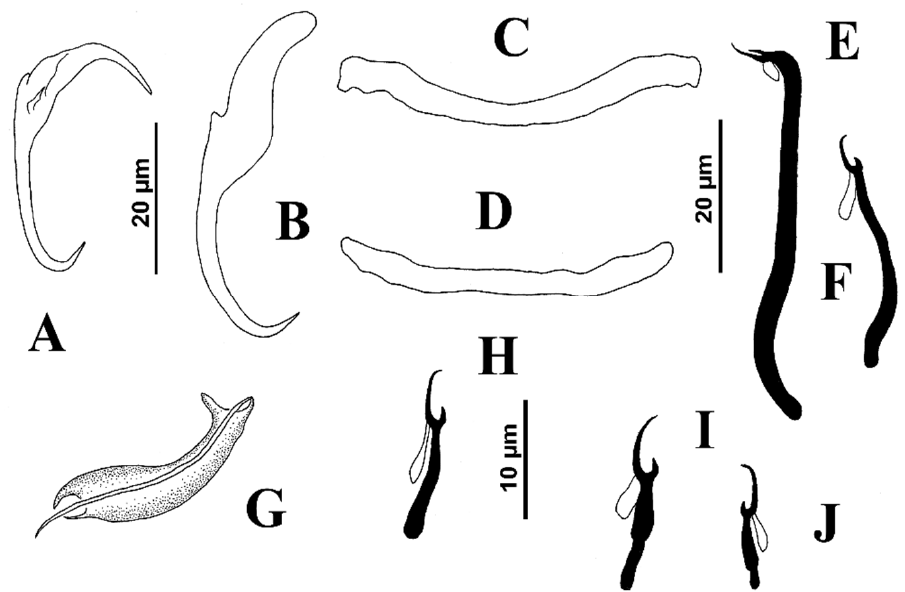
Figure 7. Haptoral structures of Neohaliotrema similium n. sp. from the beaugregory Stegastes xanthurus ( A ) Dorsal anchor ( B ) Ventral anchor ( C ) Dorsal bar ( D ) Ventral bar ( E ) Hook pair 3 ( F ) Hook pair 2 ( G ) Copulatory complex ( H ) Hook pair 1 ( I ) Hook pair 4 ( J ) Hook pair 7.